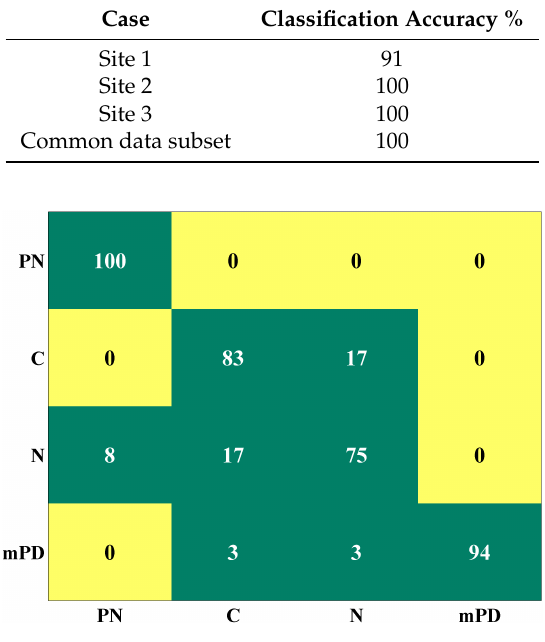
Figure 7. Confusion matrix of site